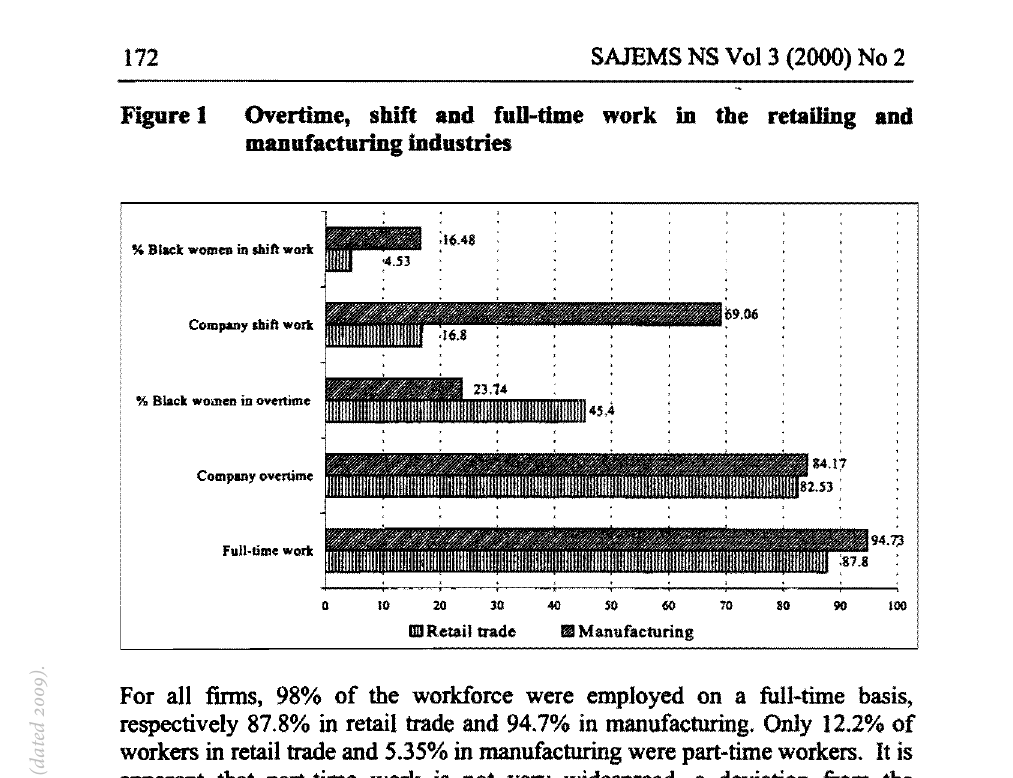
Figure 1 Overtime, shift and full-time work in the retaUing and manufacturing